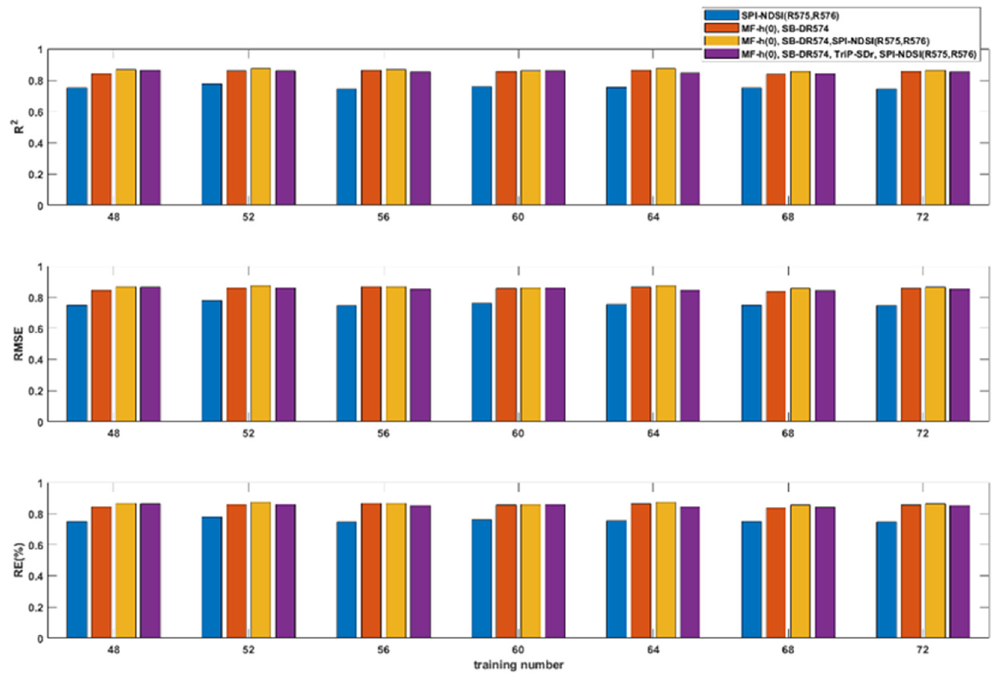
Figure 6. Three evaluation indicators of RMSE , R, and RE with different sample sizes of training set.